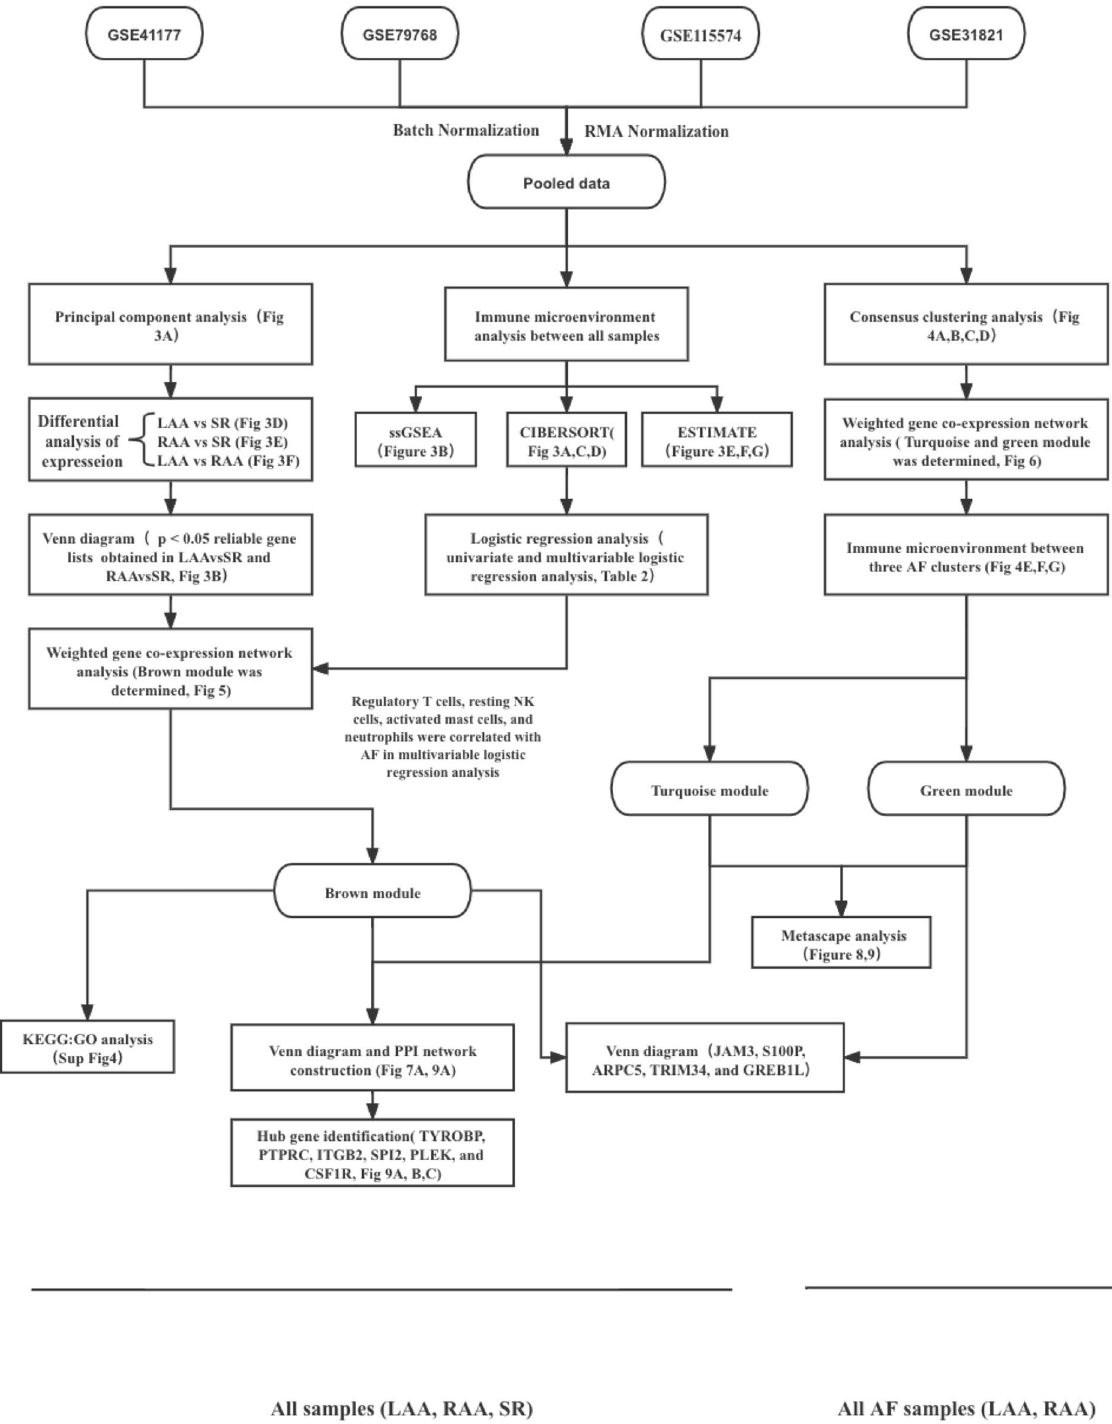
Figure 1. The analytical